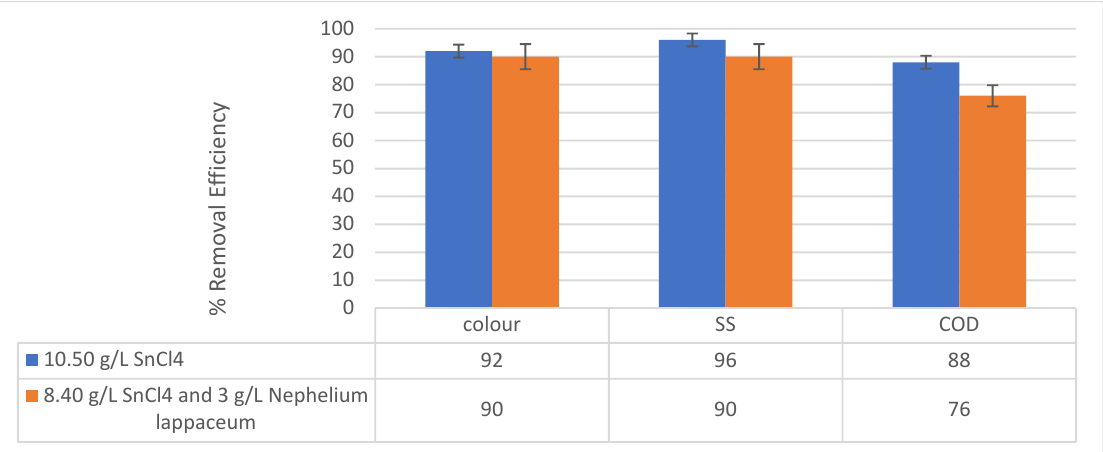
Figure 11. A summary of the removal efficiencies of pollutants conducted at pH 7 with varied dosages of SnCl 4 as coagulant and Nephelium lappaceum seed as a flocculant.